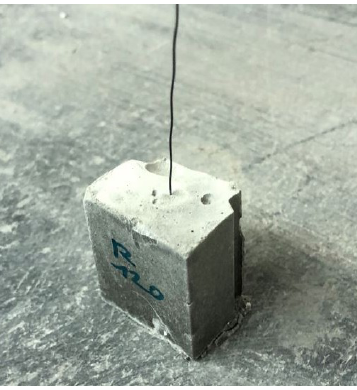
Figure 1. Prepared specimen for the pull-out